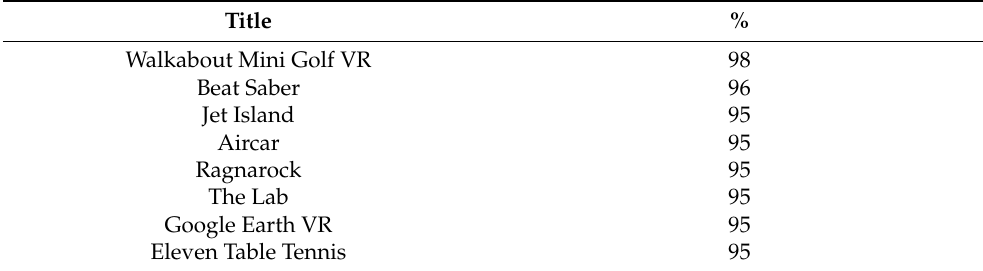
Table 8. VR applications with “overwhelmingly positive” reviews in the category of casual VR apps” [state on 6 July 2022].